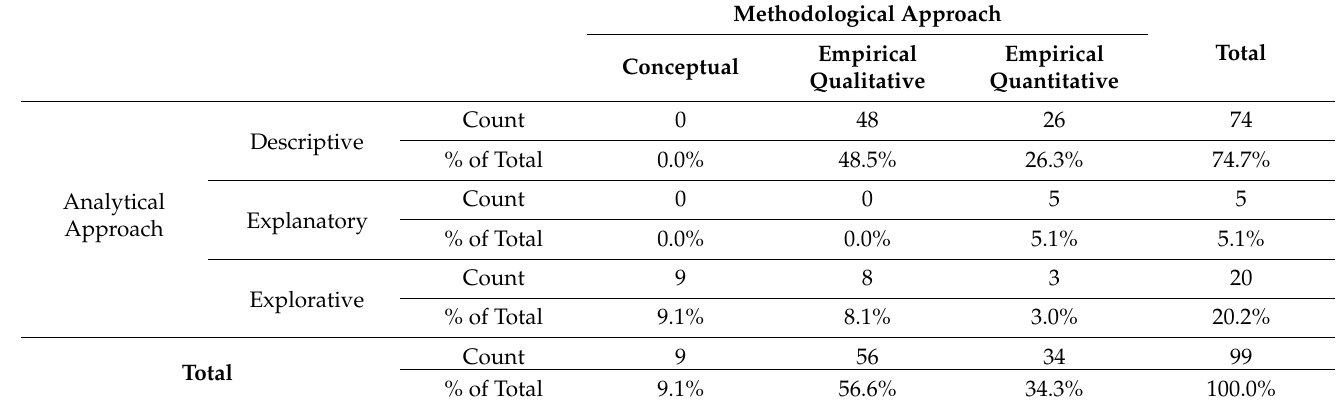
Table 3. Research